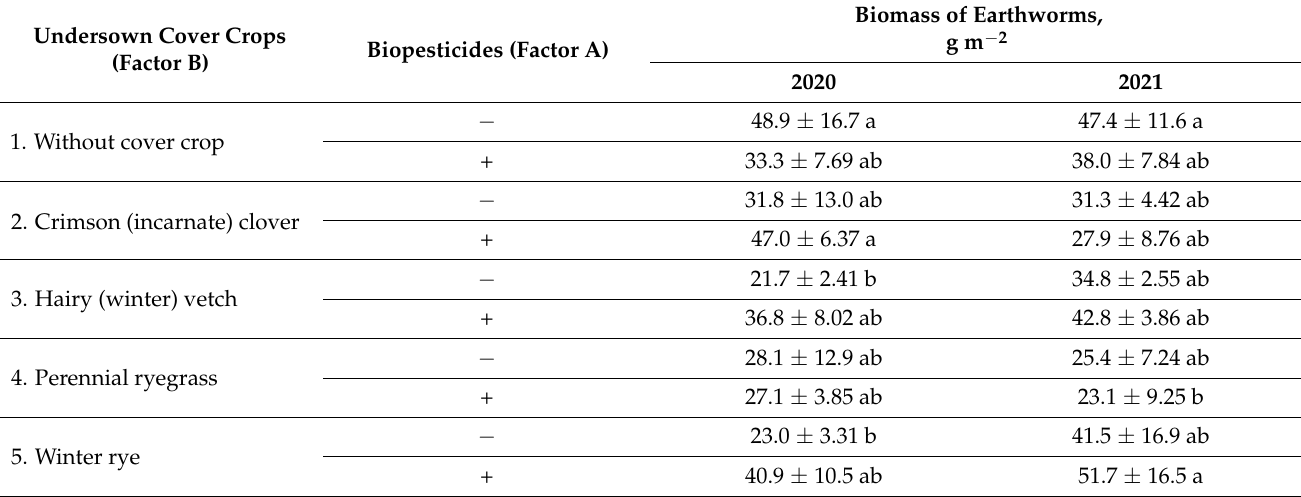
Table 4. Biomass of